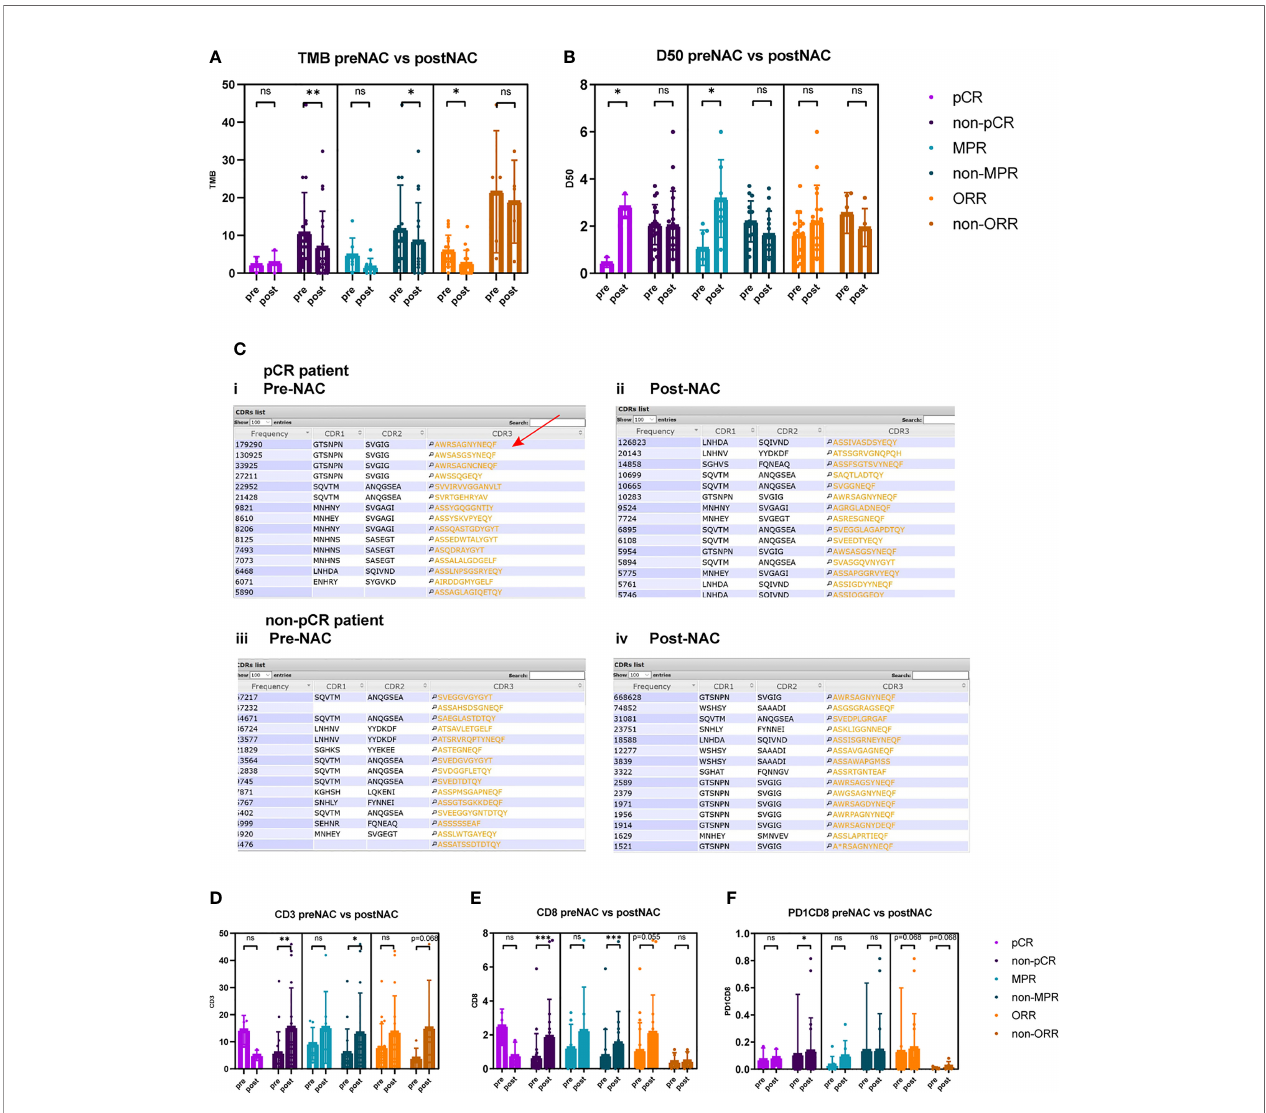
FIGURE 3 | Comparison of TMB, TCR D50, CD3 + , CD8 + , and PD1 + CD8 + cells between pre-NAC and post-NAC tumor tissues. (A) TMB reduced signi fi cantly after neoadjuvant therapy in non-pCR patients (10.6 vs. 6.8, p = 0.010), in non-MPR patients (12.3 vs. 8.5, p = 0.041), and in ORR patients (6.0 vs. 2.6, p = 0.017). TMB was not signi fi cantly different between pre-NAC and post-NAC tumors or non-cancerous residual tissues in pCR patients (2.3 vs. 2.8, p = 0.879), in MPR patients (3.4 vs. 1.6, p = 0.176), and in non-ORR patients (21.5 vs. 18.9, p = 0.500). (B) TCR D50 index signi fi cantly increased post-NAC versus pre-NAC in pCR patients (0.467 vs. 2.883, p = 0.028) and in MPR patients (1.086 vs. 3.171, p = 0.028), but not signi fi cantly change after NAC in non-pCR patients (D50 2.066 vs. 2.037, p = 0.658), and in non-MPR patients (2.203 vs. 1.667, p = 0.125), and in both ORR (1.638 vs. 2.206, p = 0.332) and non-ORR patients (2.560 vs. 1.940, p = 0.343). (C) Top 15 CDR3 motifs in pre-NAC tumors (i, iii) and post-NAC residual non-cancerous or cancerous tissues (ii, iv) of pCR and non-pCR patients. CDR3 motif is the major element recognizing the tumor speci fi c mutated antigens. The CDR3 peptide AWRSAGNYNEQF is the highly expressed TCR in pre-NAC samples of pCR patients (Red arrow) and in post-NAC samples of non-pCR patients. (D) In non-pCR patients and non-MPR patients, the percentages of CD3 + T cells signi fi cantly increased after NAC (5.9% vs. 15.3%, p = 0.003; 5.9% vs. 13.2%, p = 0.019). (E) In non-pCR patients and non-MPR patients, the percentages of CD8 + T cells signi fi cantly increased after NAC (0.8% vs. 1.9%, p = 0.001; 0.1% vs. 1.5%, p = 0.001). (F) In non-pCR patients, the percentages of PD1 + CD8 + T cells signi fi cantly increased after NAC (0.11% vs. 0.13%, p = 0.025). ns, not signi fi cant; *p < 0.05; **p < 0.01; ***p <